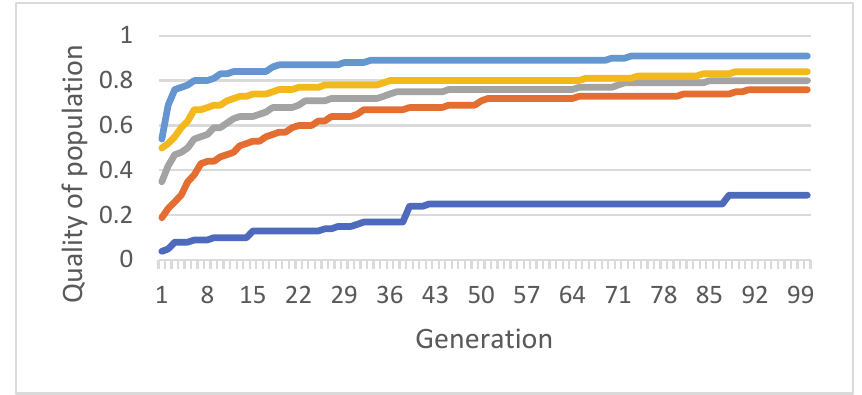
Figure 10. Convergence behavior of 5 solutions using BBA CO for Reuters dataset.